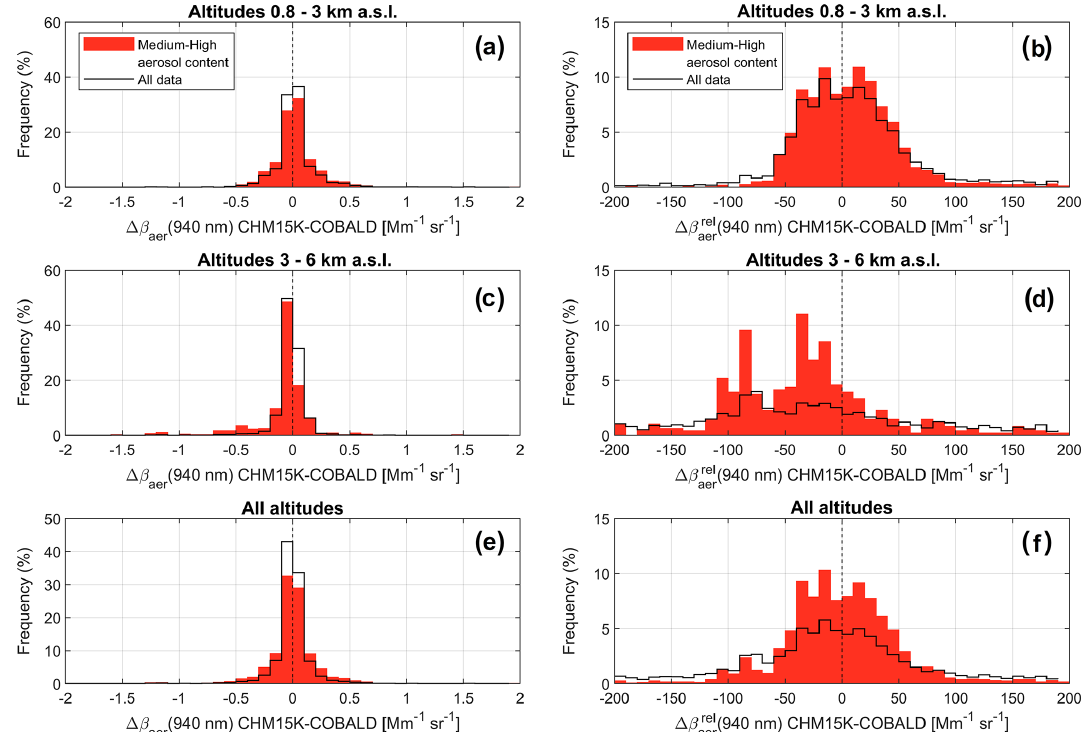
Figure 9. Statistical comparison of CHM15K vs. COBALD: frequency-of-occurrence distributions of medium-high-aerosol-content data (blue bars) and all data (black lines). Panels (a, c, e) : frequency-of-occurrence distributions of the CHM15K − COBALD difference in aerosol backscatter coefficient ( (cid:49)β aer ) at 940nm for the altitude intervals 0.8–3kma.s.l. (a) 3–6kma.s.l. (c) and 0.8–6kma.s.l. (i.e., all altitudes: panel e ). Panels (b, d, f) : same as panels (a, c, e) , with (cid:49)β aer expressed in percent units (%) relative to the COBALD measurements (i.e., (cid:49)β rel aer ). The frequency-of-occurrence distributions are calculated in (cid:49)β aer intervals of 0.1Mm − 1 sr − 1 (a, c, e) and 10% (a, c, e) . Table 3. Statistical comparison of CHM15K vs. COBALD: results for medium-high aerosol content. For each altitude interval, we show mean deviation (in both absolute units, δ , and percent units relative to COBALD, δ rel ) and standard deviation (in both absolute units, σ , and percent units relative to COBALD, σ rel ) at 940nm as well as Pearson correlation coefficient ( ρ